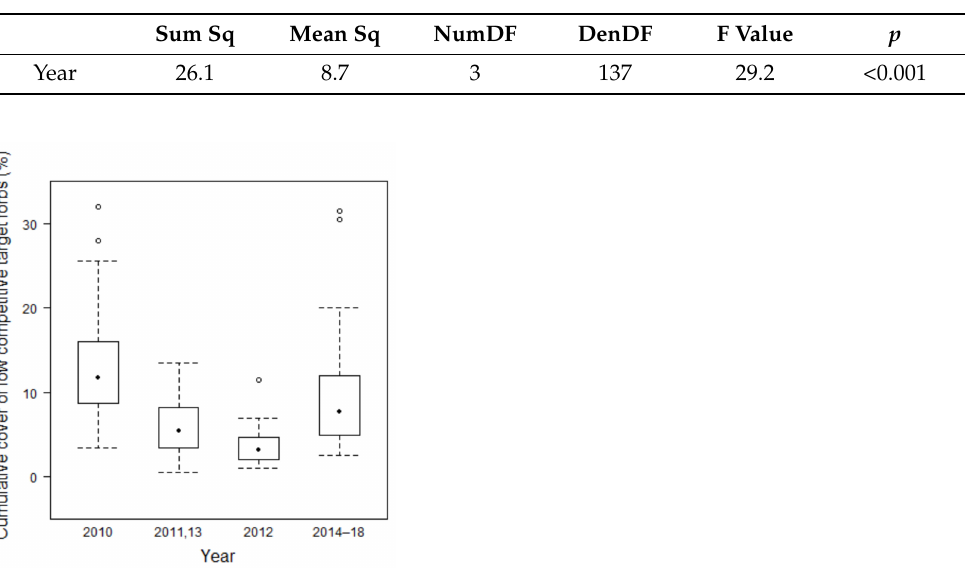
Figure A4. The minimal adequate model for the effect of time on the cumulative cover of target forbs with different fertilization treatments between 2010 and 2018 (except 2016). Table A4. Effects of year on the cumulative cover of low-competitive target forbs according to the minimal adequate model. The model had four levels for year (Figure A5).